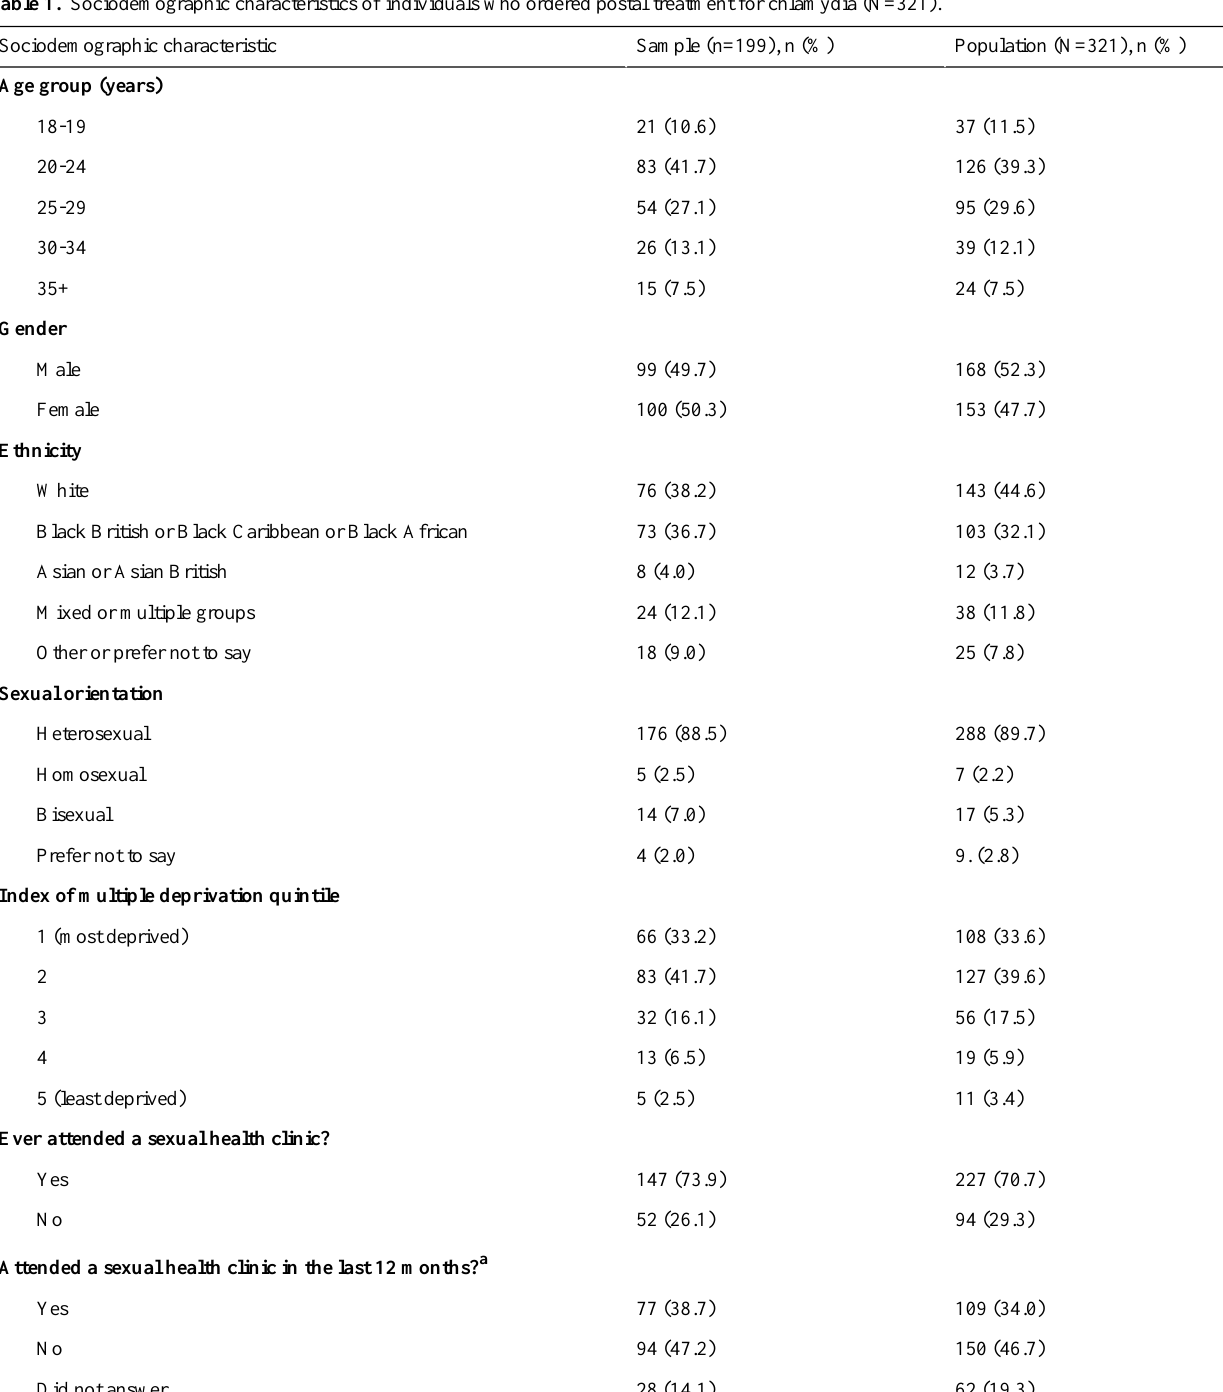
Table 1. Sociodemographic characteristics of individuals who ordered postal treatment for chlamydia